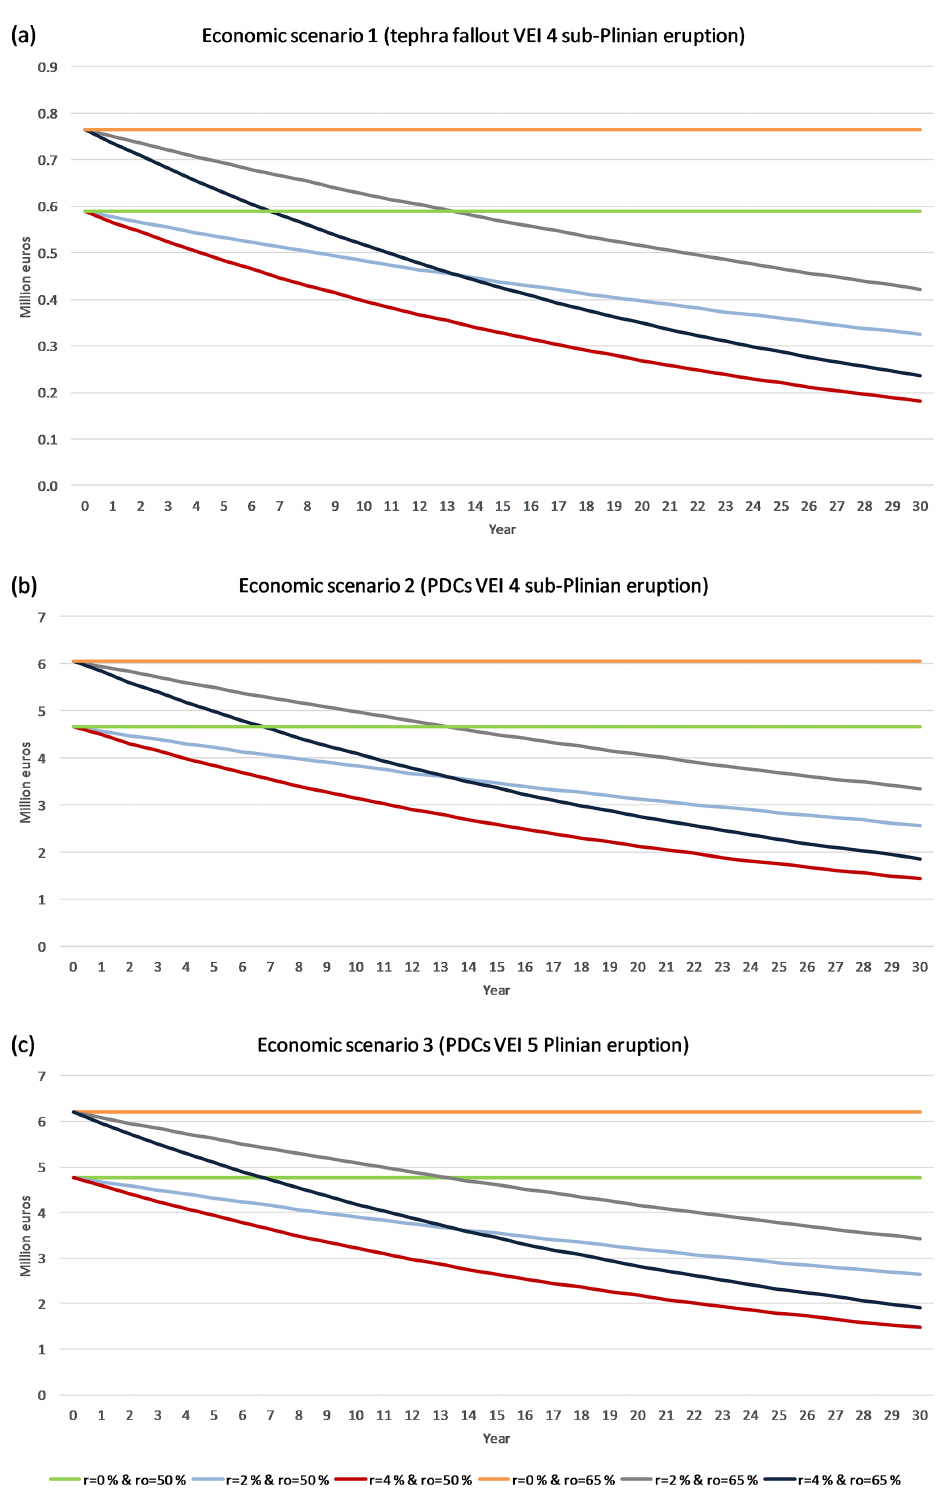
Figure 10. Loss present value after 30 years for (a) economic scenario 1 (tephra fallout VEI 4 sub-Plinian eruption), (b) economic scenario 2 (PDCs VEI 4 sub-Plinian eruption) and (c) economic scenario 3 (PDCs VEI 5 Plinian eruption), considering discount rates of 0%, 2% and 4% and occupancy rates of 50% and